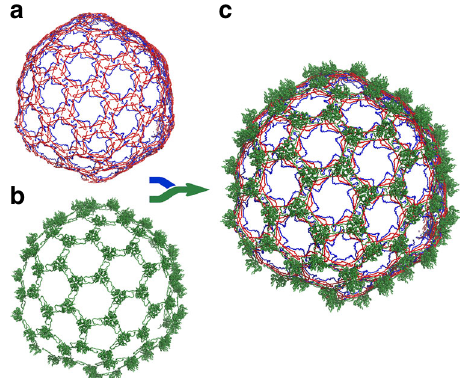
Fig. 3 The capsid proteins form two nested chainmails. a Representation of the non-covalent chainmail formed by the N-terminal arms and E-loops of the major capsid protein. The representation is the same as Fig. 2 for N-ter and the E-loops. The rest of the capsid protein has been omitted. b Ribbon representation of the outer chainmail of the auxiliary protein. c Representation of both chainmail